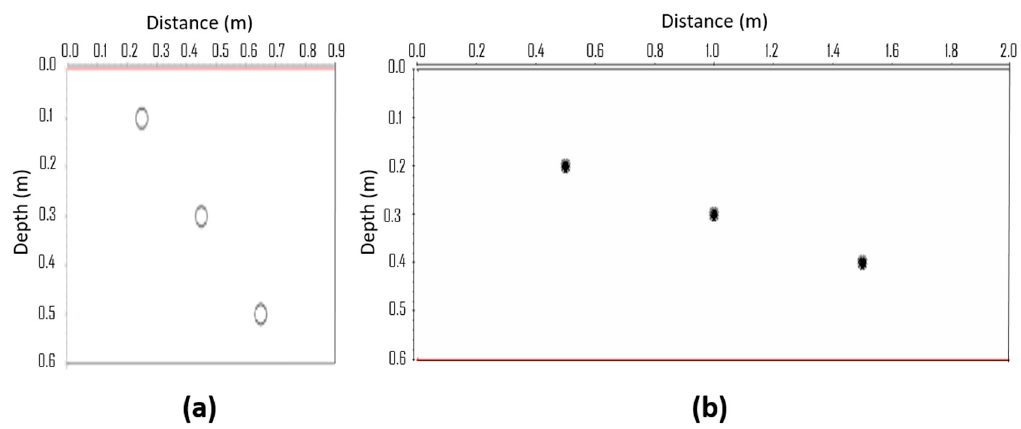
Figure 3. Side sketch of the soil boxes in the irrigation experiments. ( a ) Small soil box; ( b ) large soil box. See text for details.